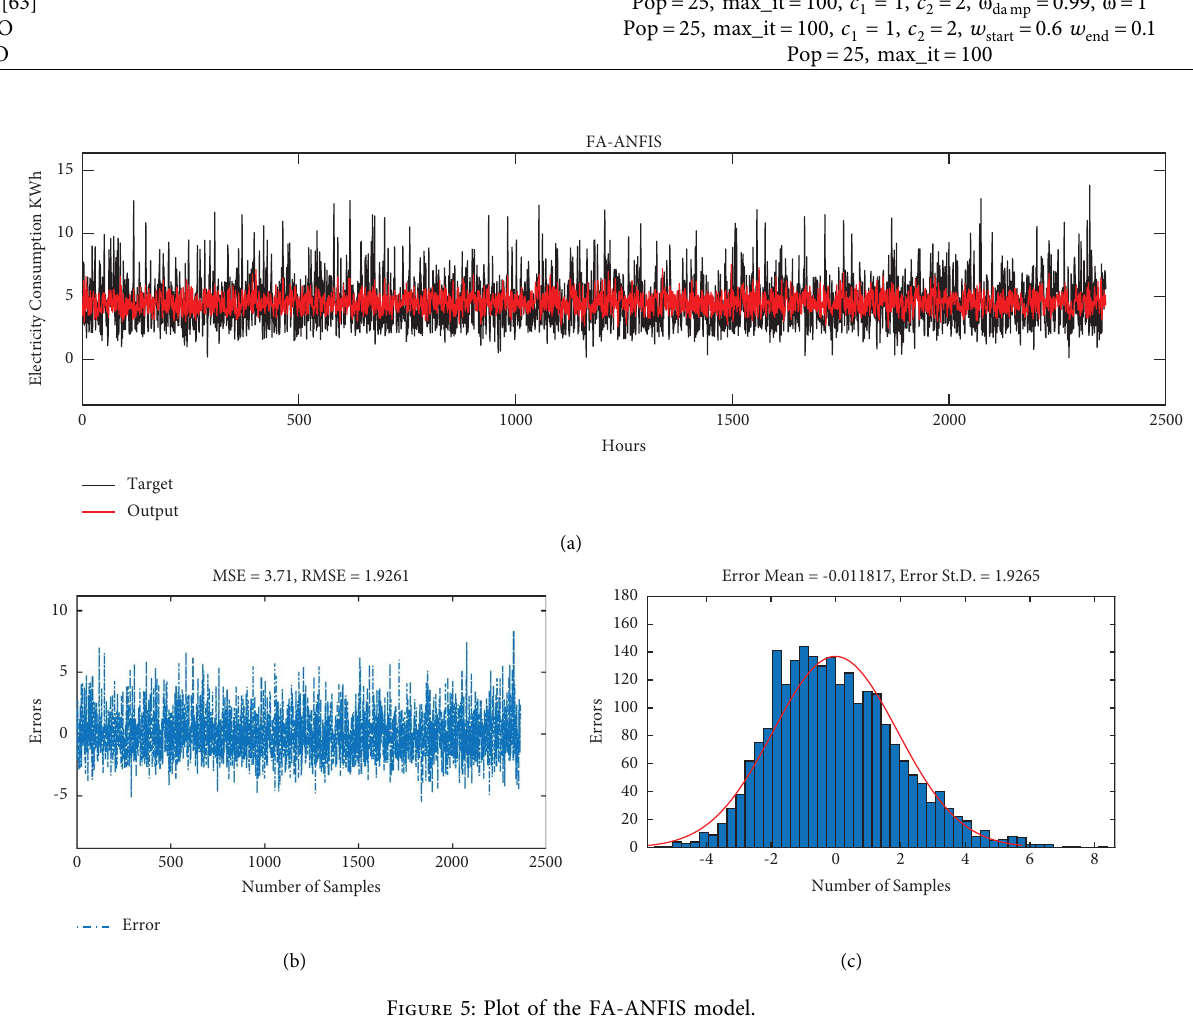
Figure 5: Plot of the FA-ANFIS